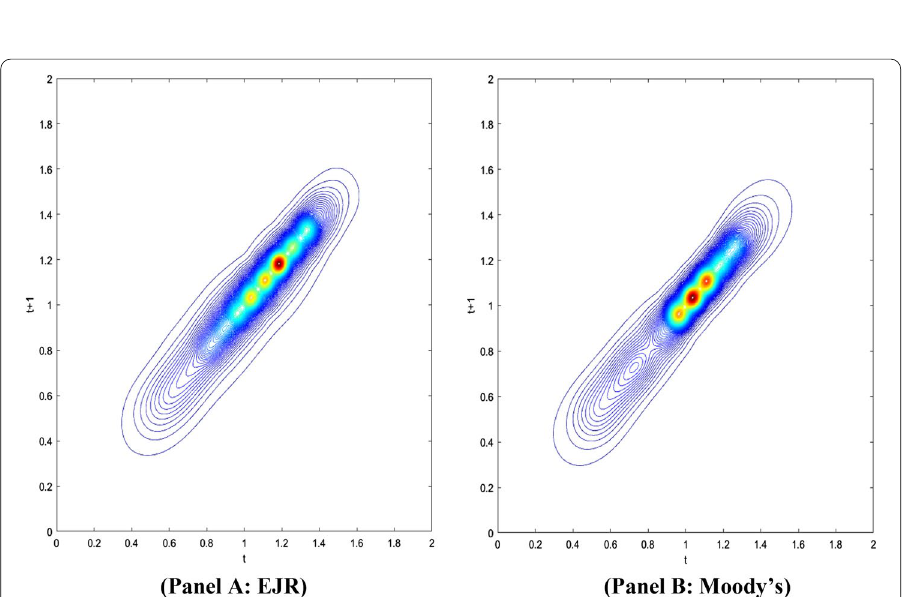
Fig. 2 Contour map of transition probability kernel for relative credit ratings assigned by EJR and Moody’s from 2011 to